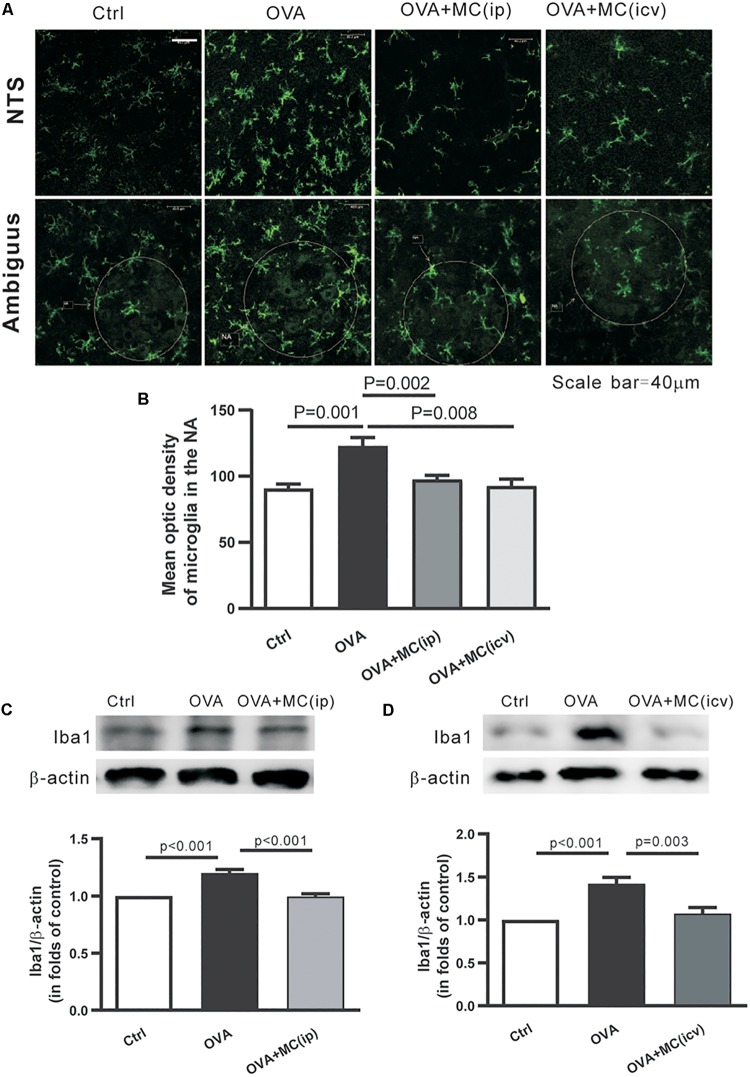
Experimental airway allergy caused activation of microglia in the brainstem particularly in the NA and nucleus tractus solitarius (NTS), which was prevented by intraperitoneal or intracerebroventricular injection of minocycline. (A) Immunofluorescent staining of OX42 in the NTS and NA of rats in control, OVA, OVA + MC(ip) and OVA + MC(icv) groups (examined in five rats in each group). Note that in the NTS and NA of rats in OVA group, the microglia stained by anti-OX42 antibody have increased number and size, and shortened processes, which suggests activation of these cells. (B) Summarized data for the optic density of OX42 fluorescence in the NA of rats in different groups, showing the significant increase in rats of OVA group. (C,D) Results from Western-blot assay (n = 6 in each group) of Iba1, showing the increased expression of Iba1 in the NA of rats in OVA group. All of the changes of microglia were prevented by minocycline treatment in rats of OVA + MC(ip) and OVA + MC(icv) groups. Dashed circles indicate the compact portion of the NA. P-values were obtained from one-way ANOVA followed by Tukey correction.